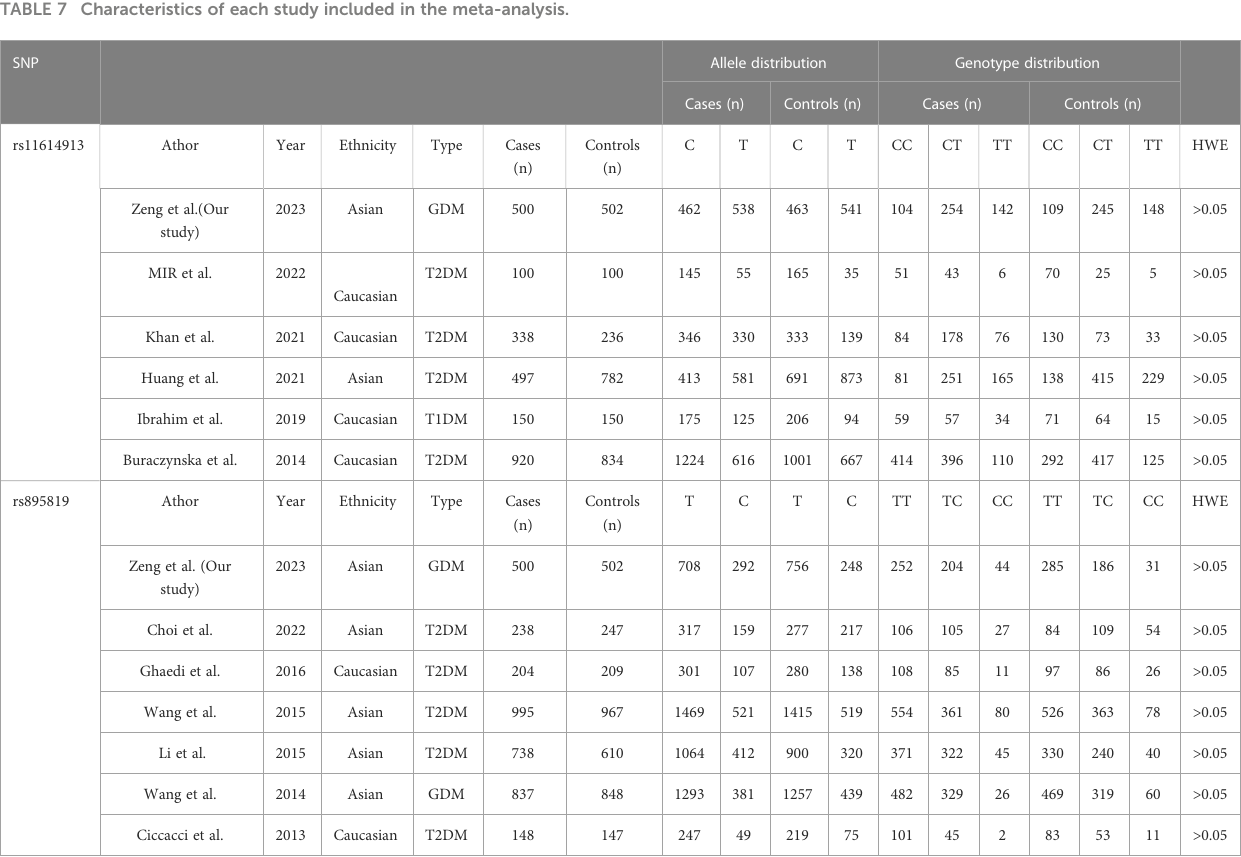
TABLE 7 Characteristics of each study included in the